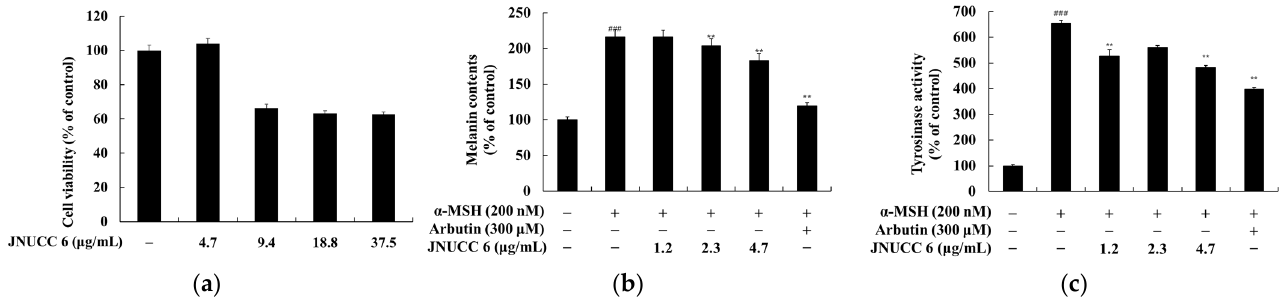
Figure 1. Inhibition of melanin production and tyrosinase activity by JNUCC6 extracts in B16F10 melanoma cells. ( a ) Cell viability was assessed using the MTT assay and represented compared to the non-treated group as percentage values. To assess the melanin content ( b ) and tyrosinase activity ( c ), the cells (5 × 10 4 cells/well) were seeded for 24 h, and then in the presence of α -melanocyte- stimulating hormone ( α -MSH), they were treated with varying concentrations of JNUCC6 extracts (1.2, 2.3, and 4.7 µg/mL) for 72 h. α -MSH (200 nM) and arbutin (300 µM) were used as a positive control and negative control, respectively. For tyrosinase inhibition assay, 3,4-dihydroxyphenylalanine (L-DOPA) was added as a substrate to cell lysates for performing the tyrosinase assay. The results are expressed as mean ± standard deviation (SD) of data obtained from four independent experiments. ### p < 0.001 compared with control group; ** p < 0.01 compared with α -MSH-treated group.